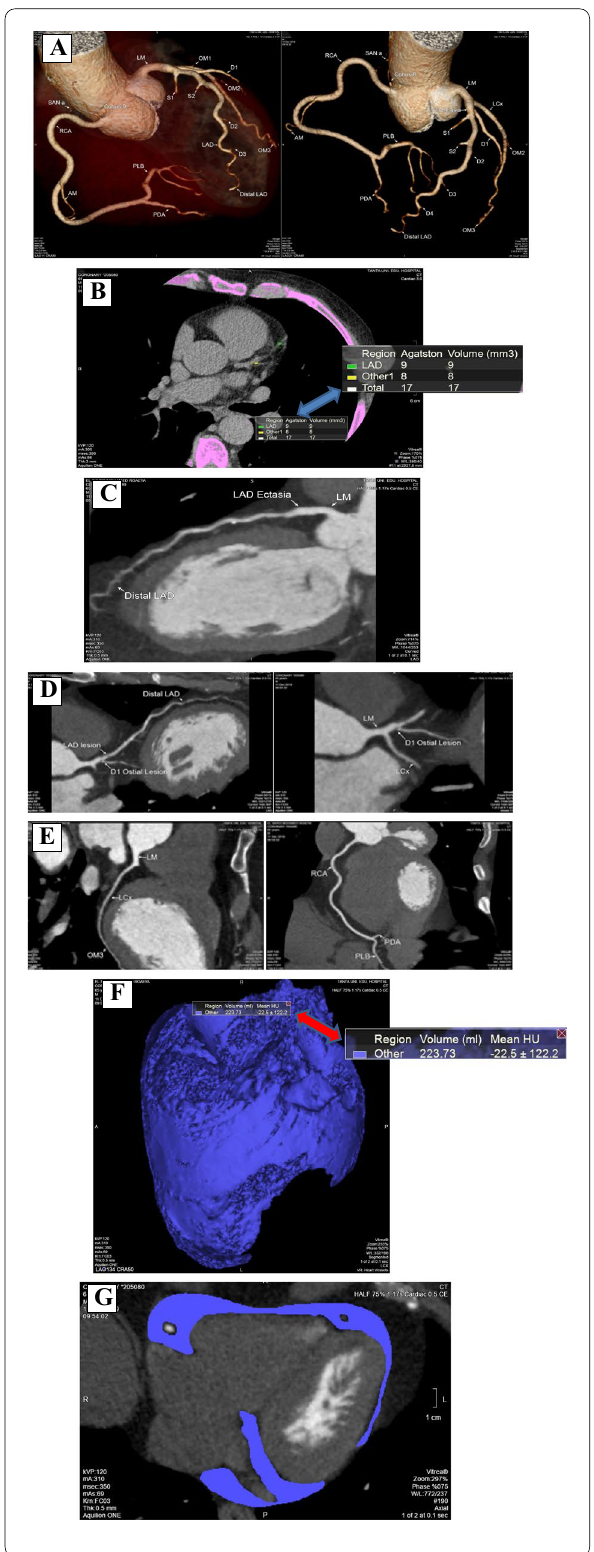
Fig. 1 A – G images: A 65‑year‑old male patient (BMI 33.6), = dyslipidemic, non‑hypertensive and non‑diabetic, complaining of chest pain. Echocardiography revealed good systolic function (EF 60%) and no regional wall motion abnormalities. A Two = different views of 3D volume rendered images showing normal origin of coronary arteries with right dominant circulation, and mild ectasia at LAD proximal LAD segment. B Axial noncontrast curved planar reformatted image showing calcium score (17) at LAD and D1. C Axial curved planar reformatted image and D Two sagittal curved planar reformatted images showing atherosclerotic showing LAD, with mild proximal LAD ectasia (5.3 mm), a soft eccentric plaque is seen at proximal to mid‑LAD segments exerting moderate stenosis (50%, length 11 mm), with another small calcified plaque with = positive remolding is seen at mid‑LAD segment without significant stenosis, and a mixed eccentric plaque is seen at D1 ostium exerting severe stenosis (70%, length 4.5 mm). E Two coronal curved planar = reformatted image showing atherosclerotic LM, LCx, OM3, RCA, PDA and PLB without significant disease. F 3D volume rendered image and G 2D axial multiplanar reformatted image showing epicardial